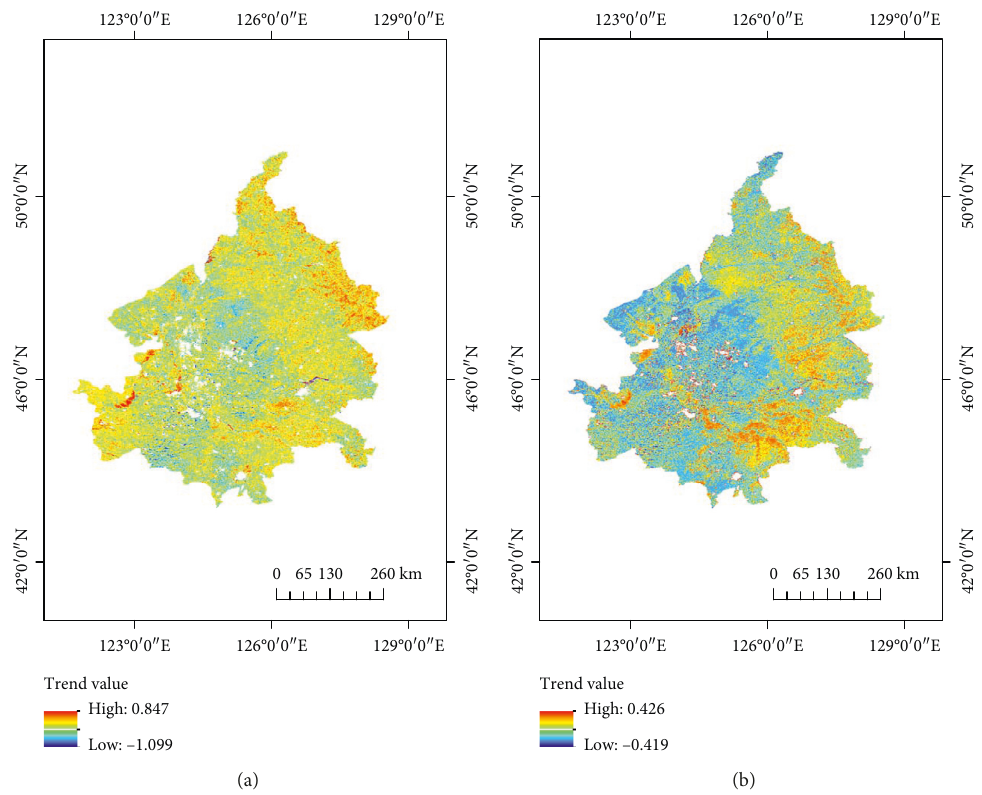
Figure 8: Spatial distribution of WUE and CUE residuals in the SNP from 2001 to 2015: (a) spatial distribution of WUE residual changes and (b) spatial distribution of CUE residual